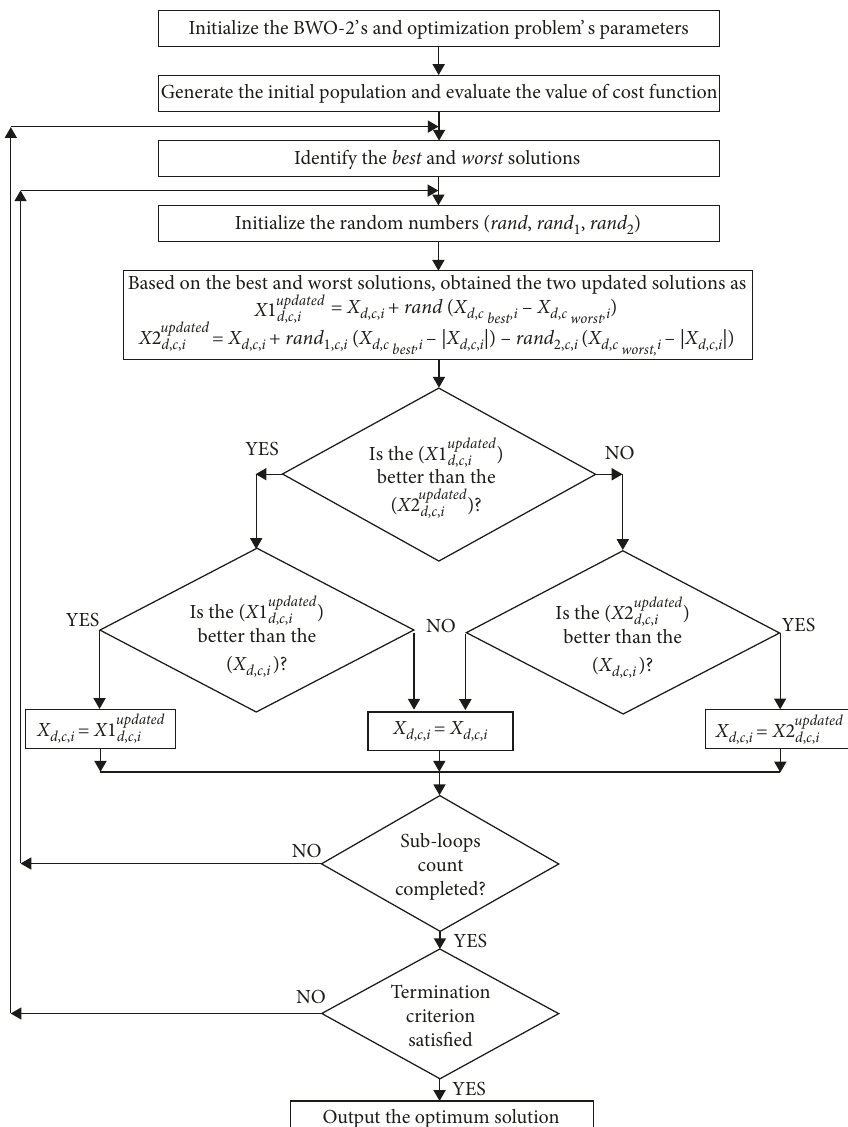
Figure 7: Flowchart of